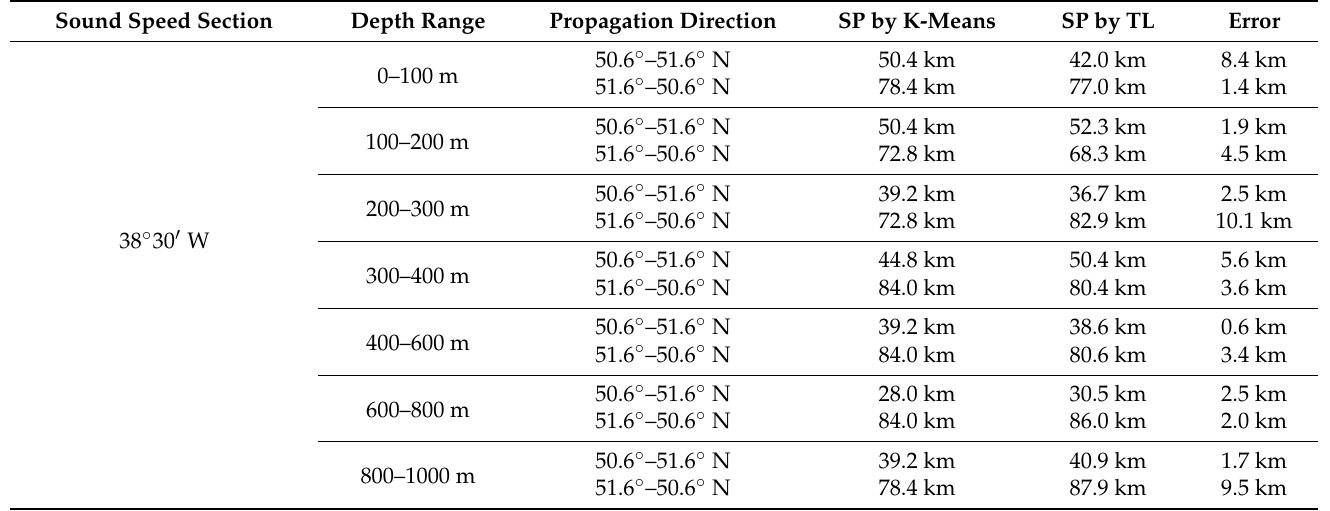
Table 3. The comparison of the accuracy of the K-means algorithms on the identification of the frontal zone in different depth ranges at 38 ◦ 30 (cid:48) W section (SP by K-means means the starting point of the frontal zone obtained by K-means, SP by TL means the starting point of the frontal zone obtained by calculating the TL, Error means the difference between SP by K-means and SP by TL).